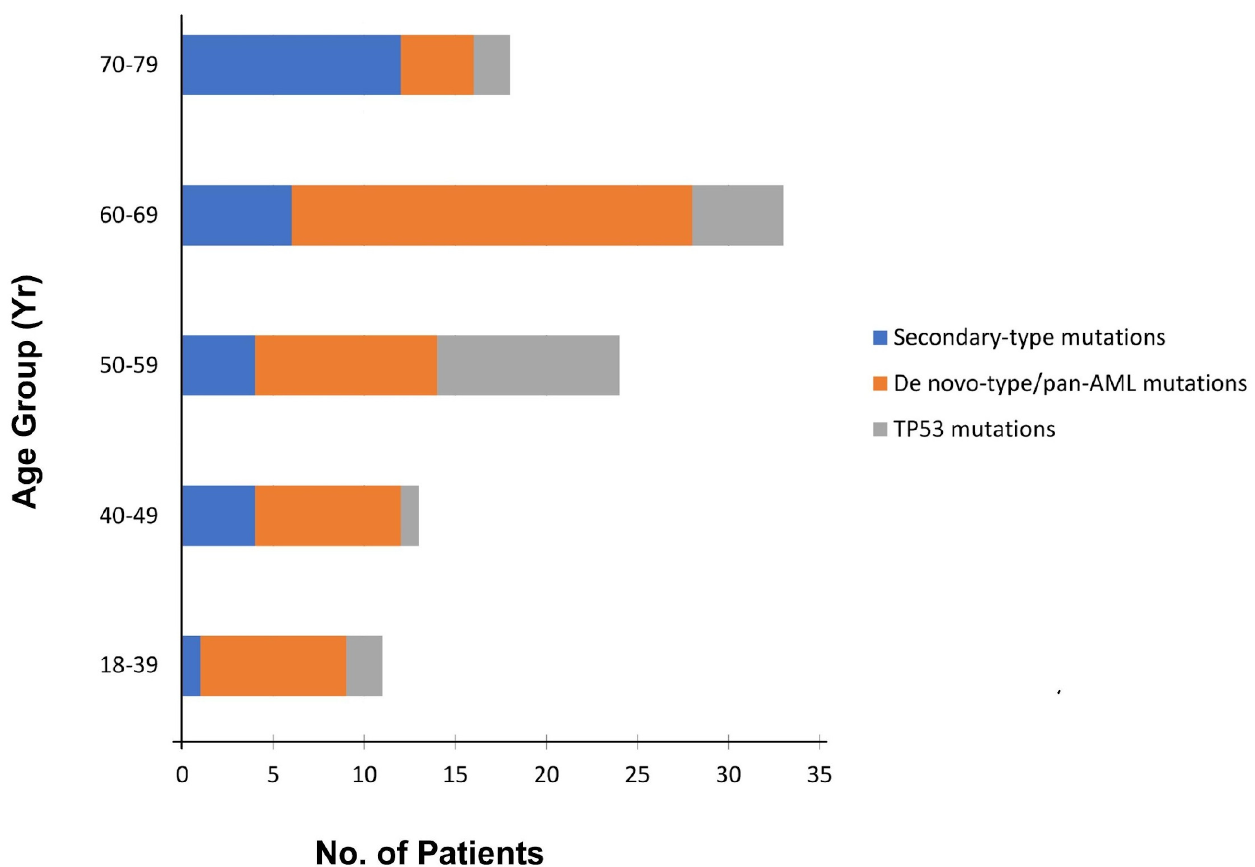
Figure 4. Distribution of the three distinct subtypes of somatic mutations (“secondary-type”, TP53 , and “de novo”-type/pan-AML mutations) among 217 patients with t-AML, according to age at onset (modified from [8]).